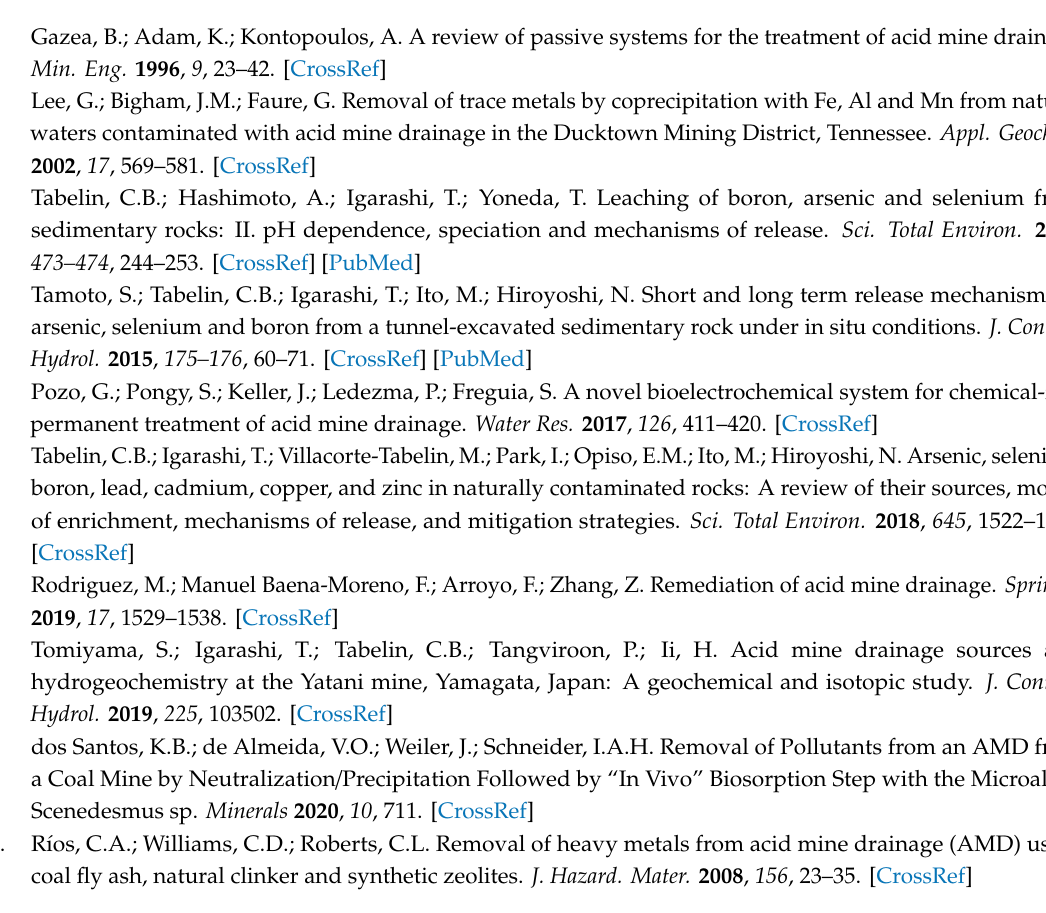
Figure S1. Changes in the As species in the solutions during the experiments with Ca(OH) 2 at a decrease in the solution / reagent ratio. Figure S2. Changing As species in solution during the experiment with Na 2 S at a decrease in the water / rock ratio. Figure S3. The change in As species during the experiment with NaOH at a decrease in the solution / reagent ratio. Figure S4. Comparison of the changes in the physicochemical parameters of the solution in the experiments. Figure S5. Comparison of changes in elemental concentrations in experiments. Figure S6. The amount and phase composition of the resulting precipitate in the experiment with Ca(OH) 2 . Hereinafter: numbers above circles denote the amount of As removed from the solution; Figure S7. The amounts and phase compositions of the resulting suspensions in the experiment with Na 2 S. Figure S8. The amounts and phase compositions of the resulting suspensions in the experiment with